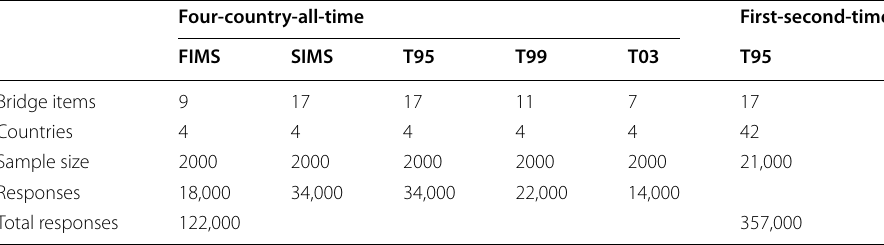
This table shows the number of item responses in the two linking approaches used for the bridge between SIMS and TIMSS 1995. Weighted sample sizes are applied with senate weights that sum up to 500 per country